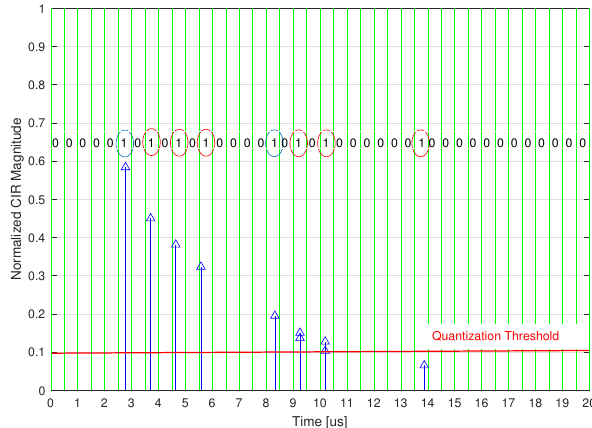
Figure 11. CIR of Scenario